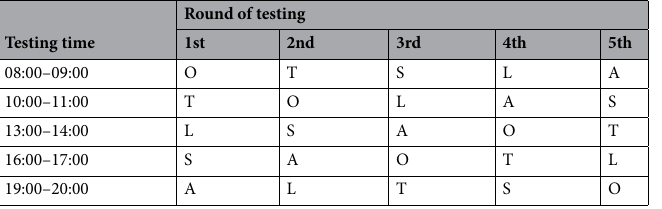
Table 1. Times of the experiments for each treatment in the laboratory simulation. This table only represents the times of experiments for one individual from the six individuals that were used in the experiments. O, T, L, S and A represent the oxygen, temperature, light, sound and gas flow treatments, respectively.